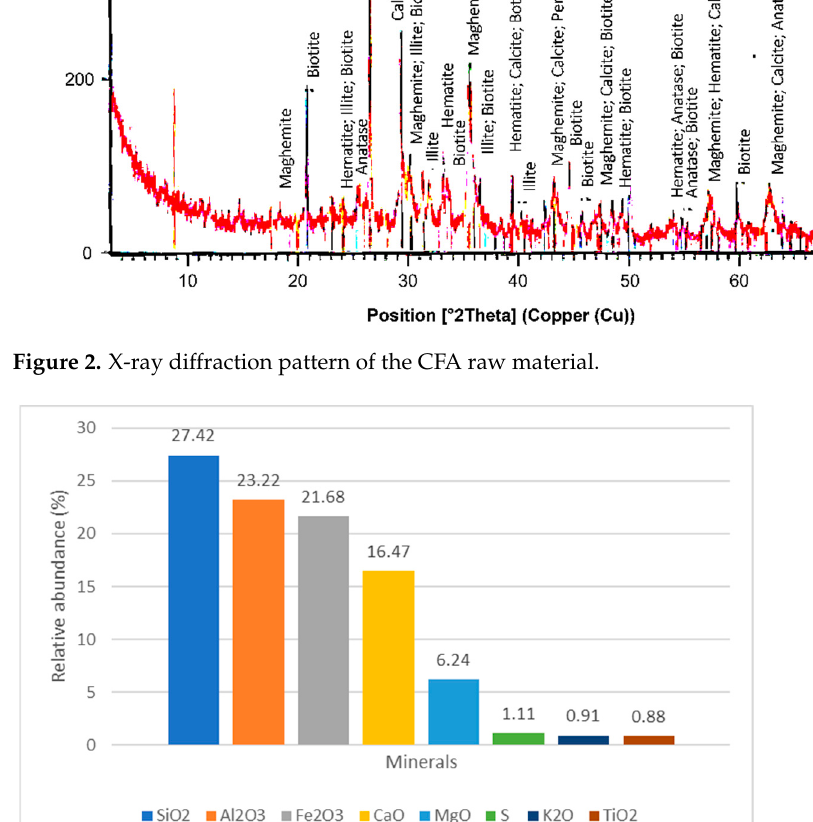
Figure 2. X-ray diffraction pattern of the CFA raw material.